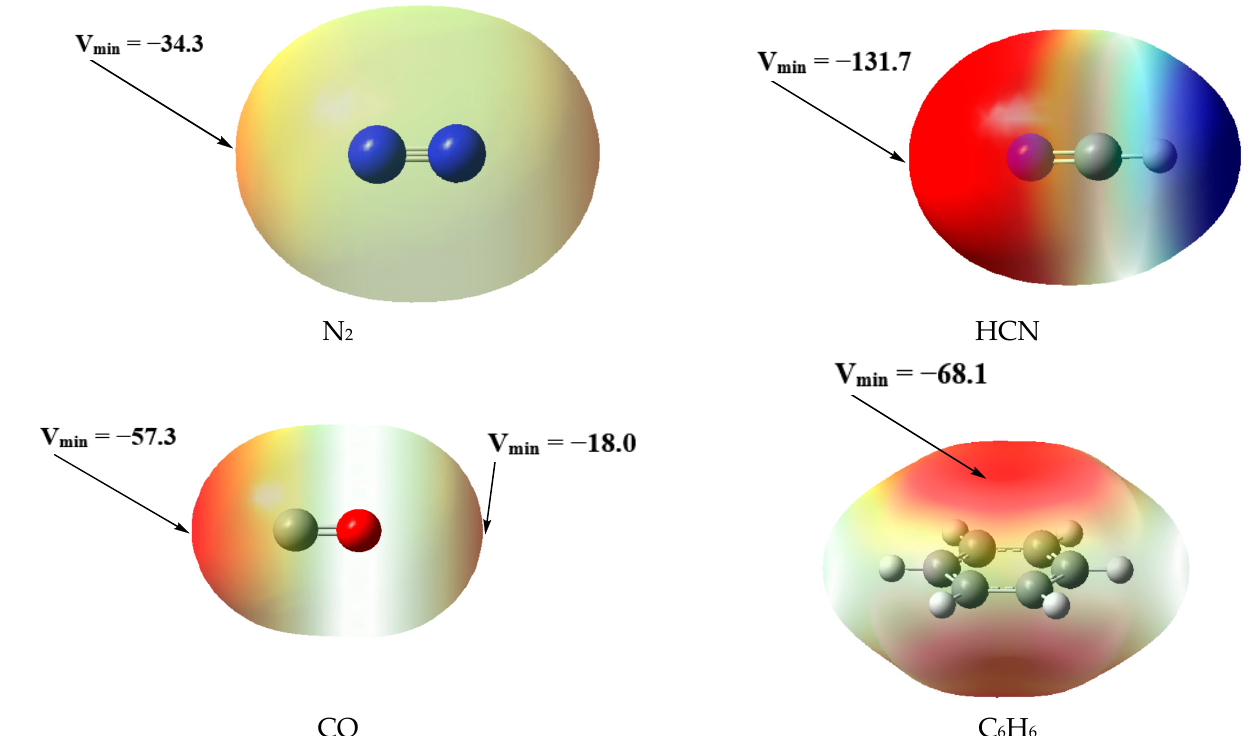
Figure 4. MEP surfaces of the selected Lewis bases at the MP2/aug-cc-pVDZ level, V S,min in kJ/mol.